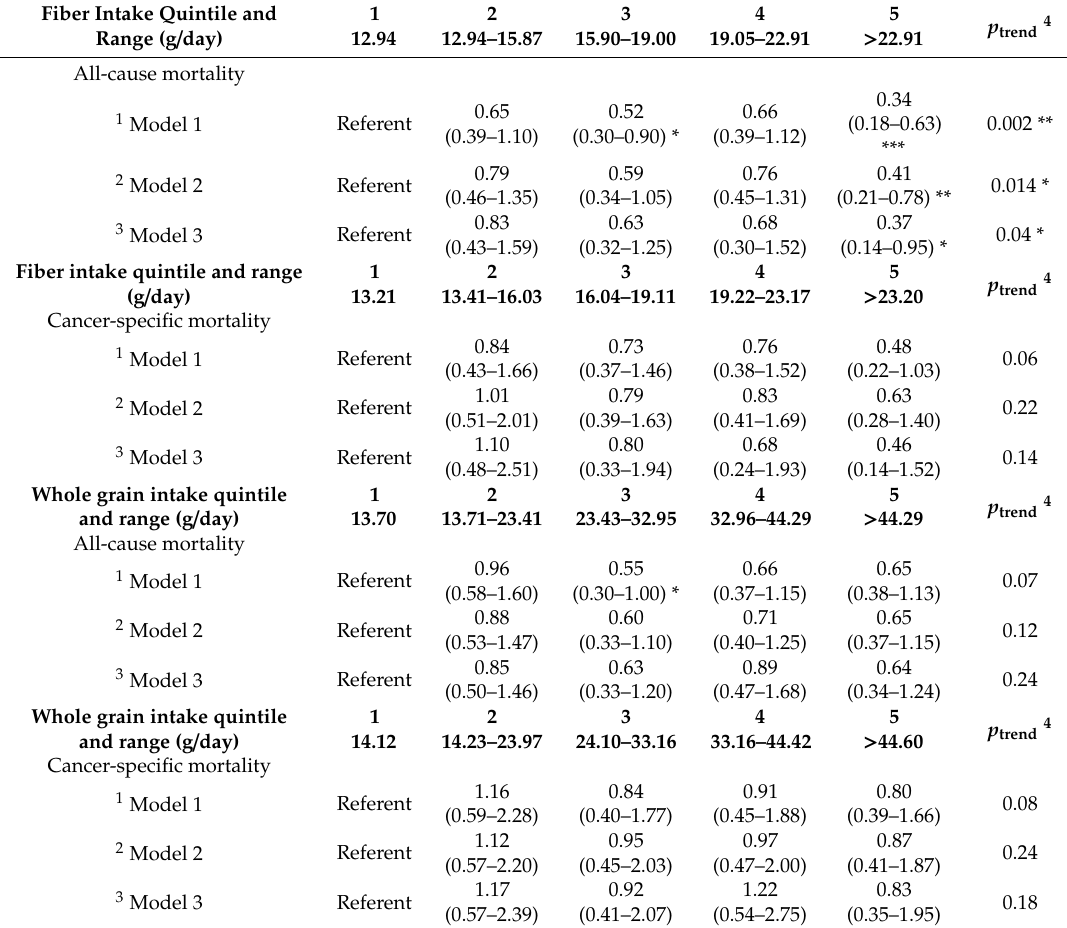
Table 3. Multivariable hazard ratios and their 95% confidence intervals of mortality risk by pretreatment total dietary fiber or whole grain consumption quintiles.